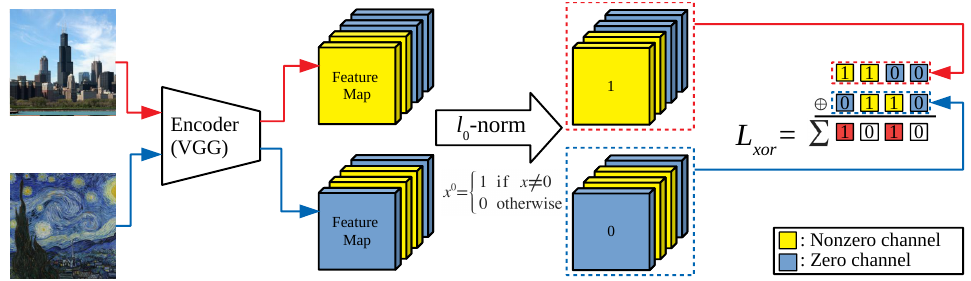
Figure 2. The process of calculating xor loss: The quantitative positional variation in zero-response channels can be measured by counting the number of consistent zero/non-zero-response channel through